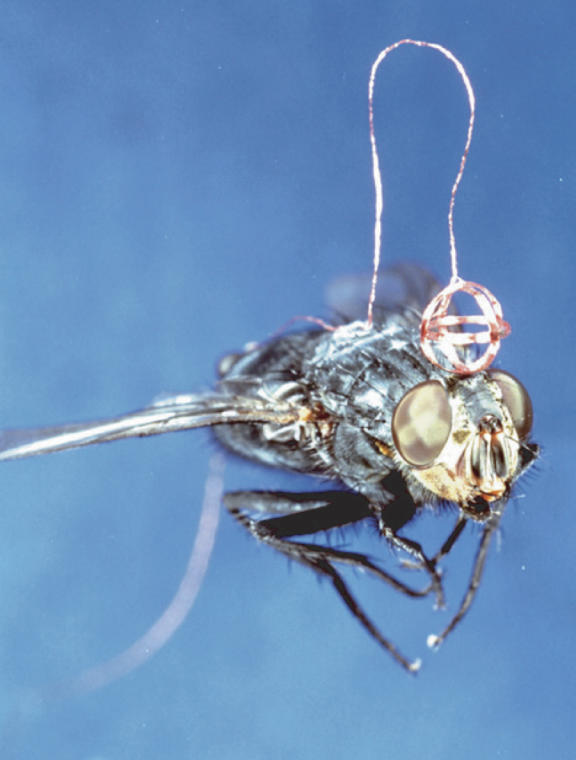
HSE neurons in the blowfly allow the fly to extract visual information about the depth structure of the world during flight